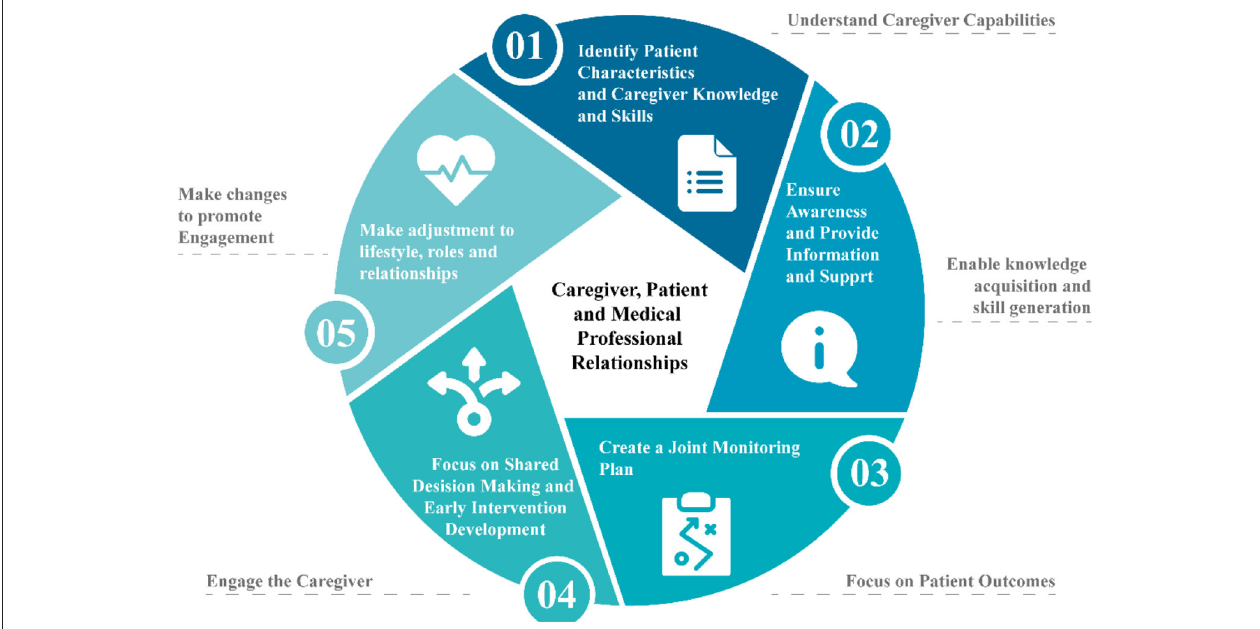
FIGURE 1 | Model for defining caregiver engagement process in health planning and policy